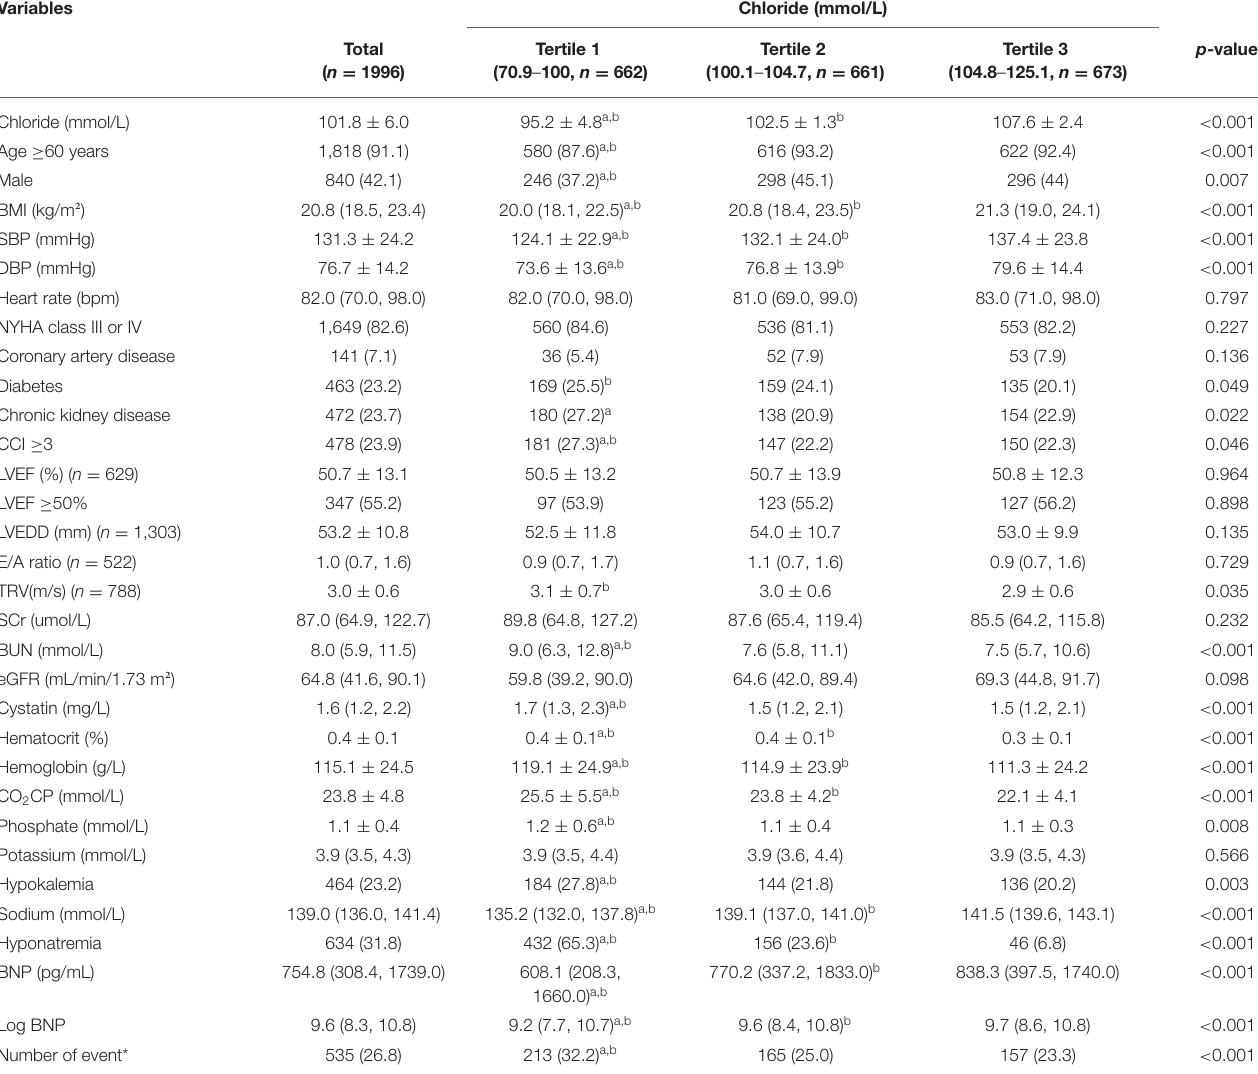
TABLE 1 | Baseline characteristics according to chloride